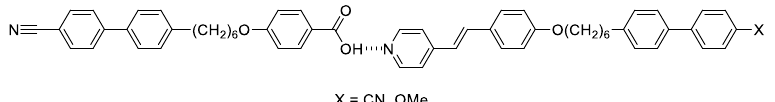
Figure 2. Structure of the CB6OBA: m B6OS hydrogen-bonded supramolecular trimers, where m = C (nitrile), 1O (methoxy).